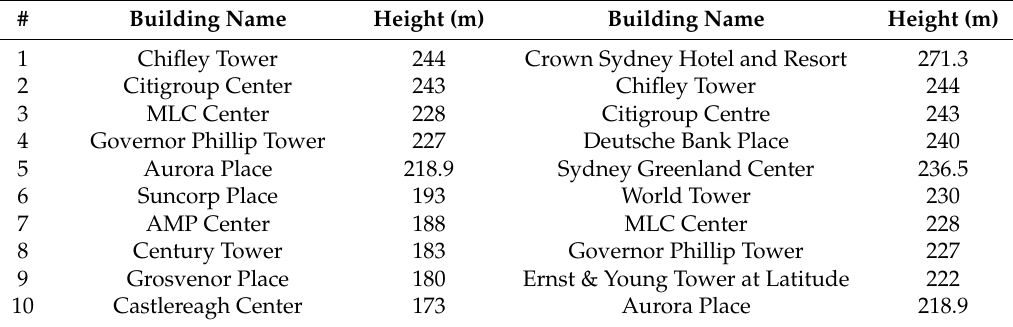
Figure 14. Sydney in 2000 and 2020. Table 24. Sydney’s 10 tallest skyscrapers in 2000 and 2020.